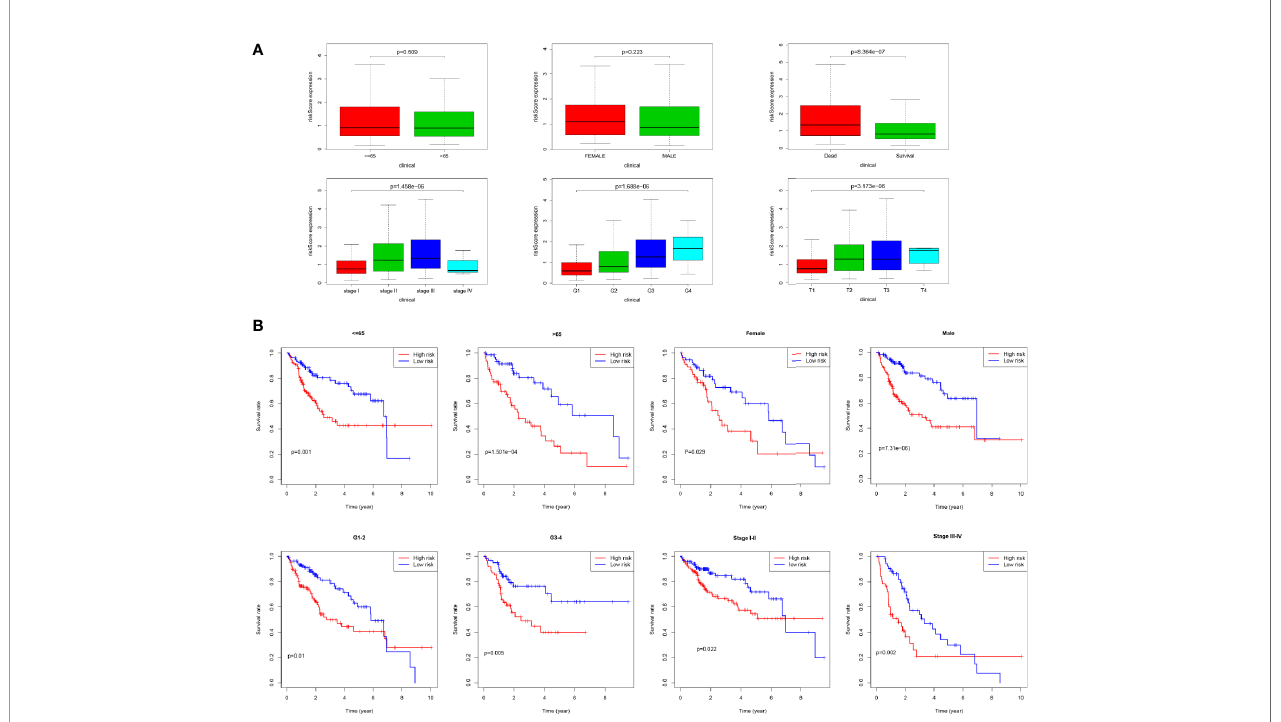
FIGURE 9 | Correlation of risk score and clinical characteristics. (A) Risk score distribution between different clinical characteristics; (B) Kaplan-Meier survival analysis of the signature strati fi ed by clinical characteristics.